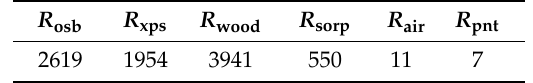
Table 3. Optimized near-exponential decay parameters for each non-poly wall.